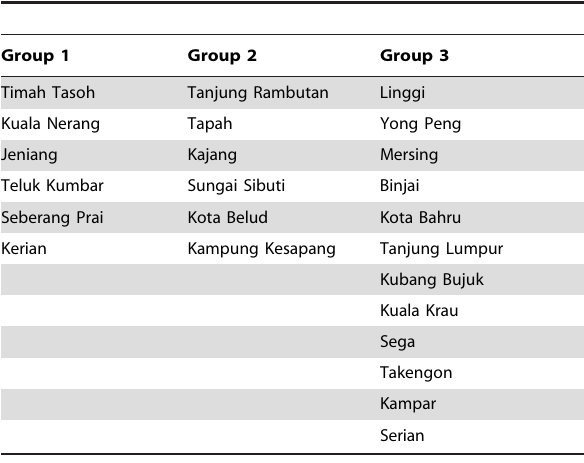
Table 3. SAMOVA analysis on C. striata populations inferred from mtDNA ND5